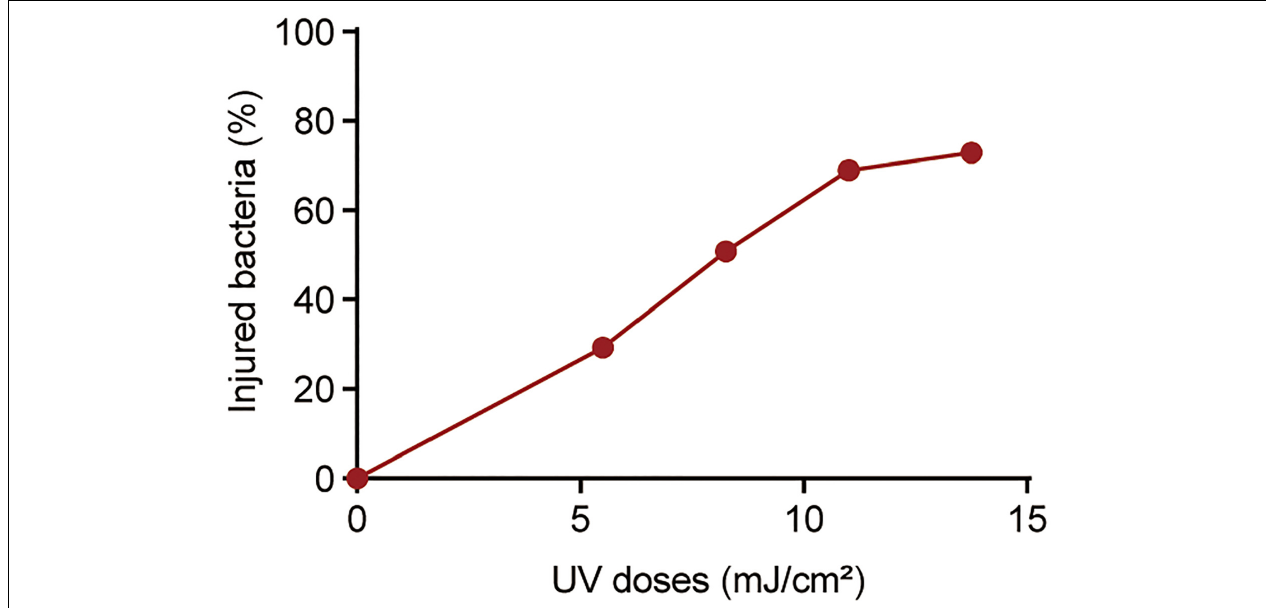
FIGURE 3 | Percentage of injured bacteria following UV exposure. The baseline conditions were as follows: the initial concentration of P. aeruginosa was ∼ 10 9 CFU/mL (pH 7.2, 20 ◦ C). Data are shown as the mean ± standard deviation (s.d.). (n = 3).